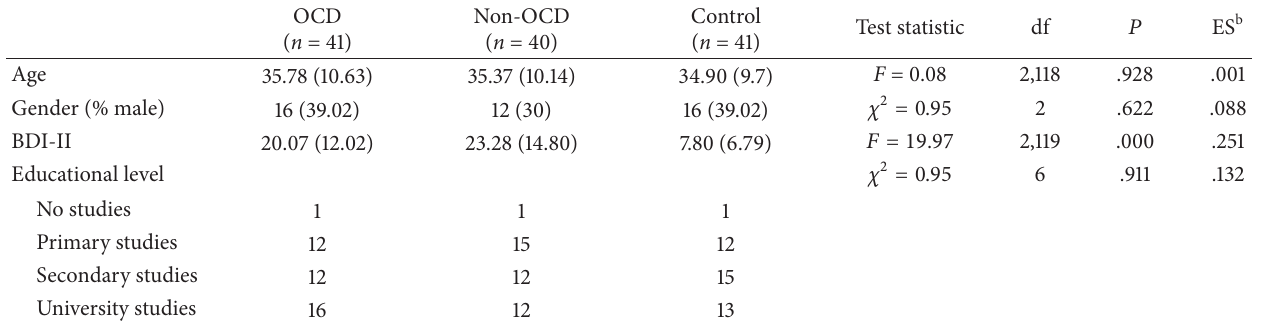
Table 1: Demographic characteristics and BDI-II results of subjects with OCD, without OCD, and control subjects a .